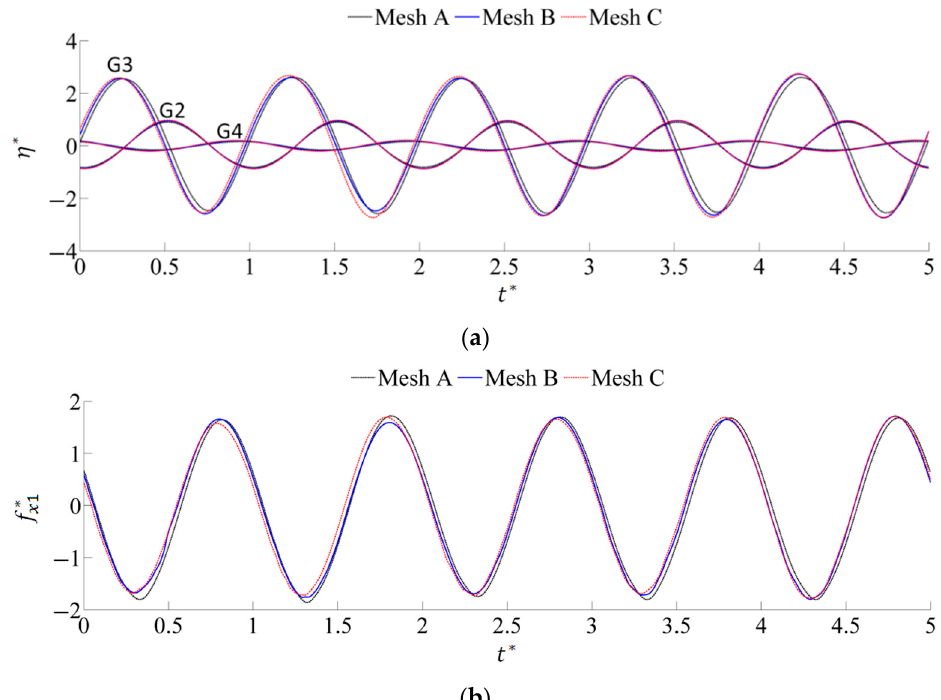
Figure 4. Time history curves of C6 using different mesh settings over five steady-state periods: ( a ) η ∗ versus t ∗ at G2, G3, and G4; ( b ) f ∗ versus t ∗ x 1